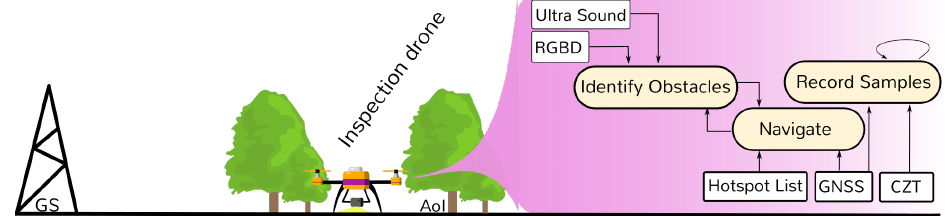
Figure 6. Inspection